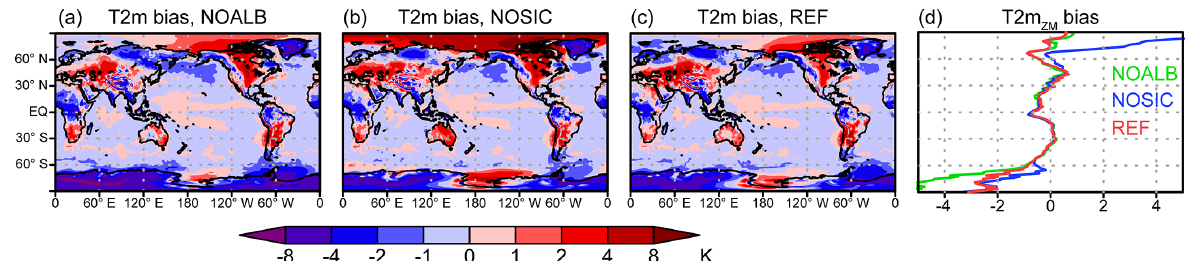
Figure 11. Bias in the simulated surface air temperature (K) by NICAM16-7S against JRA-55 reanalysis averaged for June 2004–May 2005. The NOALB (a) , NOSIC (b) , and REF (c) runs are shown. The zonal mean biases of the surface air temperature for the NOALB (green), NOSIC (blue), and REF (red) runs are shown in (d) .